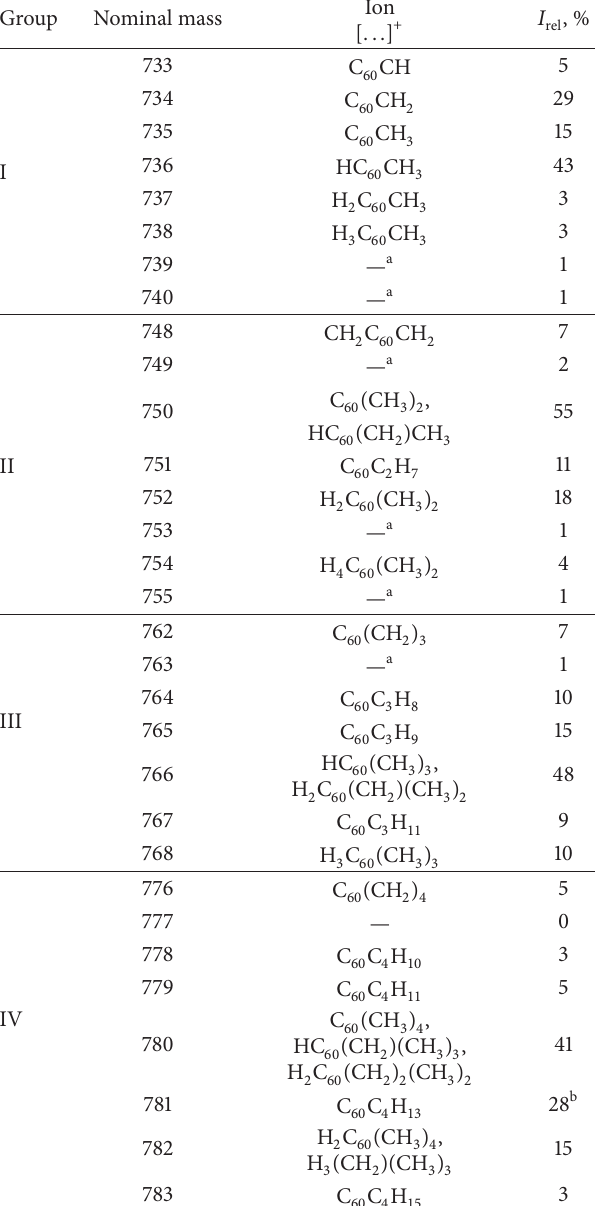
Table 2: Monoisotopic mass spectrum (nominal masses and abun- dances( 𝐼 rel )normalizedto100%totalofeachgroup)forthefirstfour groups of the products from the reaction of C 60 with silane 1 in the IC of a mass spectrometer under EI.